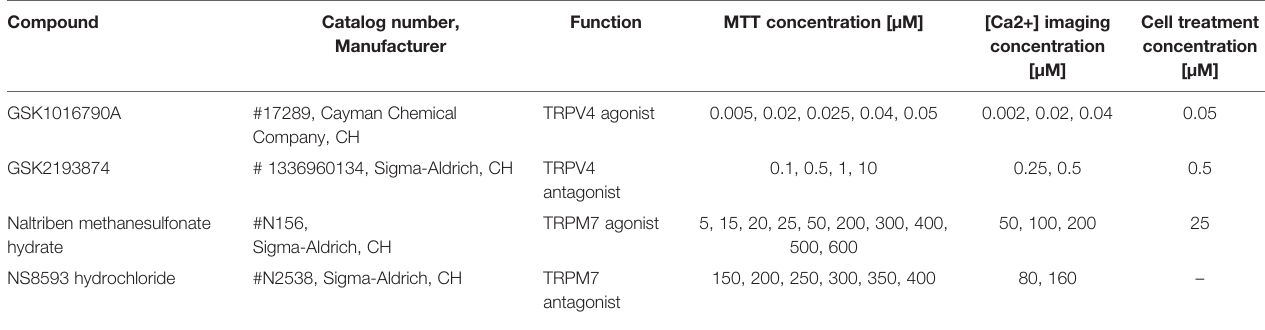
TABLE 1 | Chemical compounds and